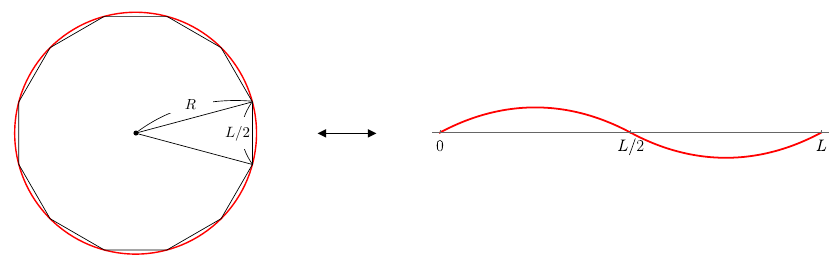
Figure 5 . The approximation of the circular string by taking its segments with a chord length L/ 2 . For a perturbative analysis, we take a short chord length which satisfies eq.